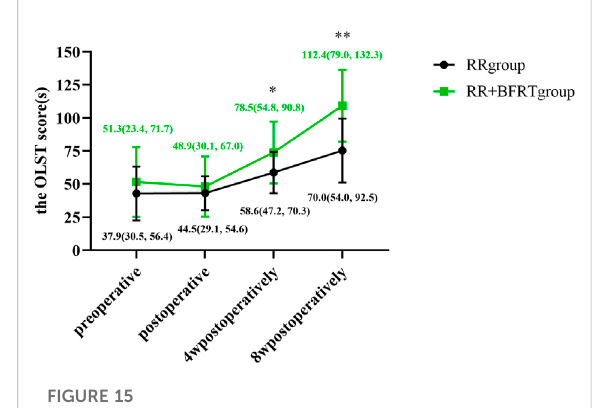
FIGURE 15 Comparison of OLST scores between RR group and RR + BFRT group at different time points (s). “ * ” indicates a signi fi cant change ( p < 0.05); “ ** ” indicates a signi fi cant change ( p < 0.01). Values are presented as interquartile range. RR Group: routine rehabilitation group; RR + BFRT Group: routine rehabilitation + blood fl ow restriction training group.